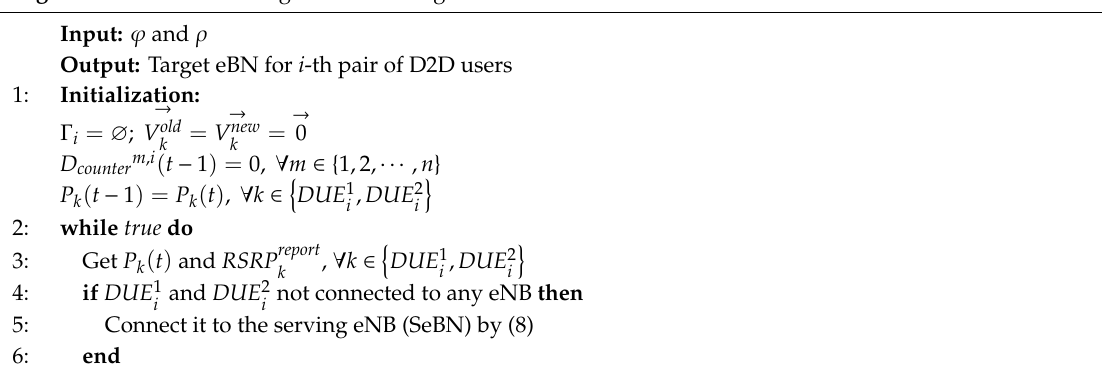
Algorithm 1 Handover Target Selection Algorithm